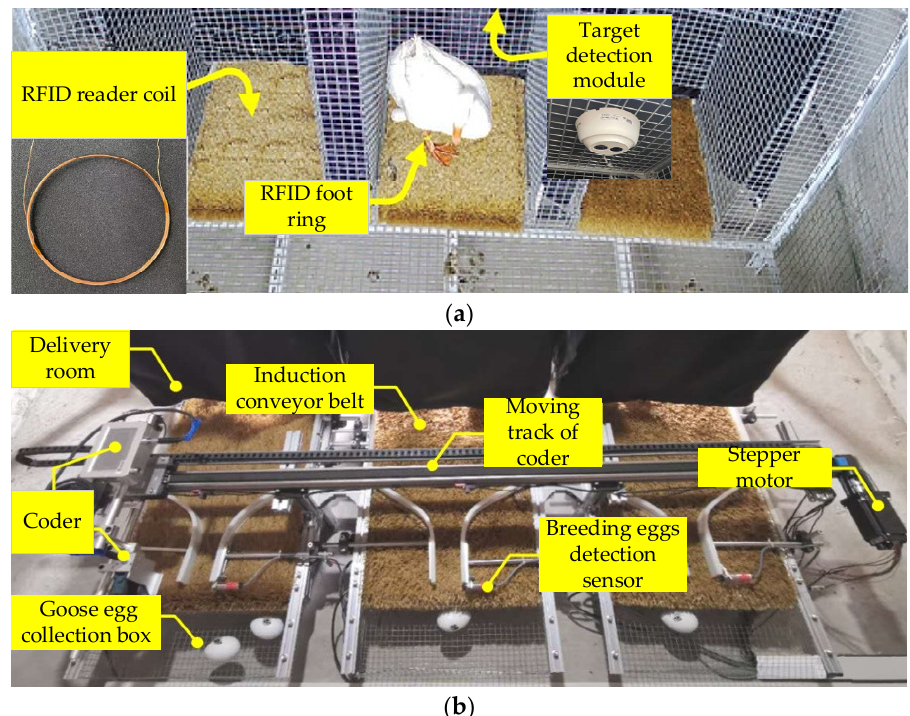
Figure 2. The prototype of goose breeding egg identification and coding system. ( a ) Front view of the system. ( b ) Back view of the system.